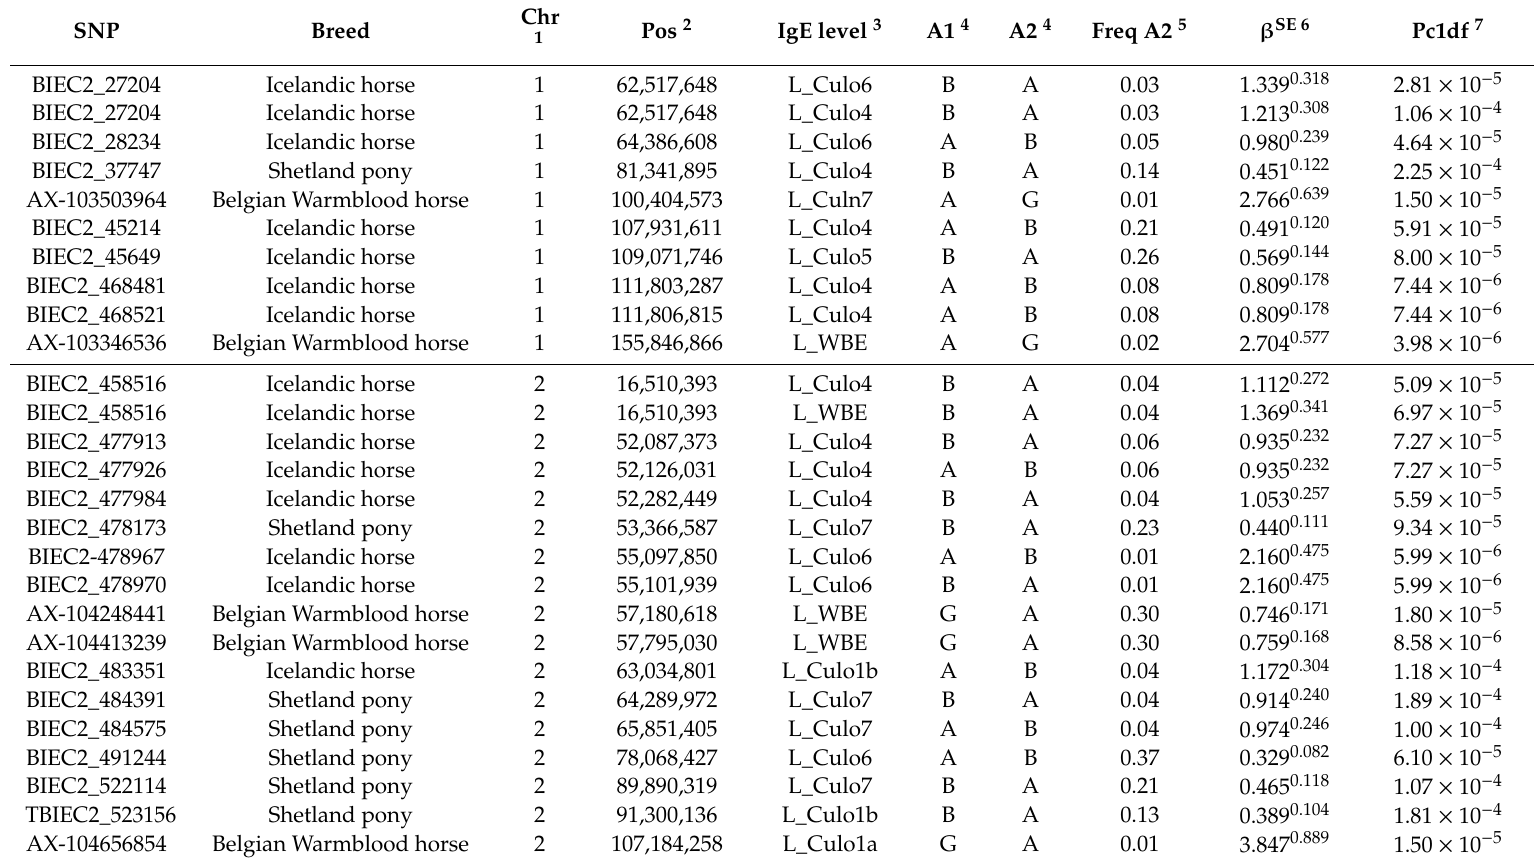
Table A2. SNPs most significantly associated with IgE levels against various Culicoides antigens in Belgian Warmblood horses, Icelandic horses and Shetland ponies. As none of the SNPs passed the Bonferroni corrected significance threshold (1.01 × 10 − 6 in Shetland ponies, 9.50 × 10 − 7 in Icelandic horses, and 1.05 × 10 − 7 in Belgian Warmblood horses), per breed the 50 most significantly associated SNPs are presented, including location, allele frequency, allele substitution e ff ect and p